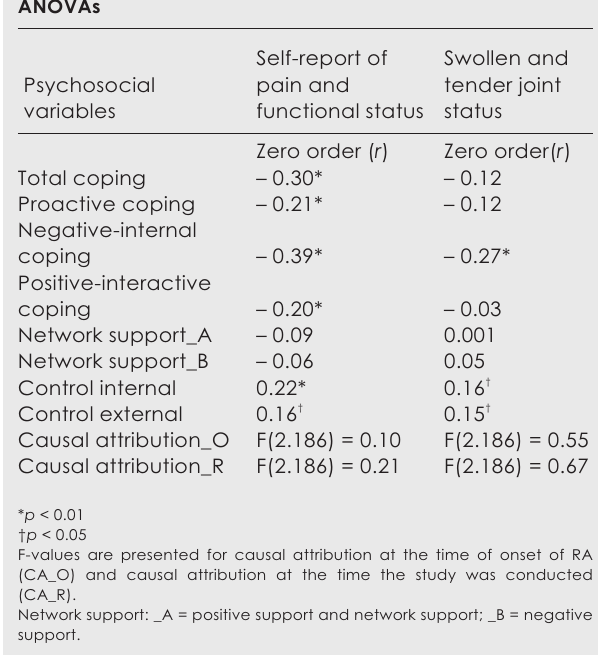
Table III. Pearson’s product-moment correlation coefficients ( r ) between psychological variables and health